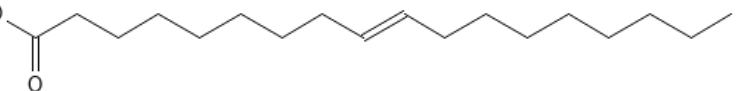
Figure 3. Oleic acid chemical structure, obtained with Draw Structure software by PubChem (https://pubchem.ncbi.nlm.nih.gov/#draw=true (accessed on 8 October 2021)).